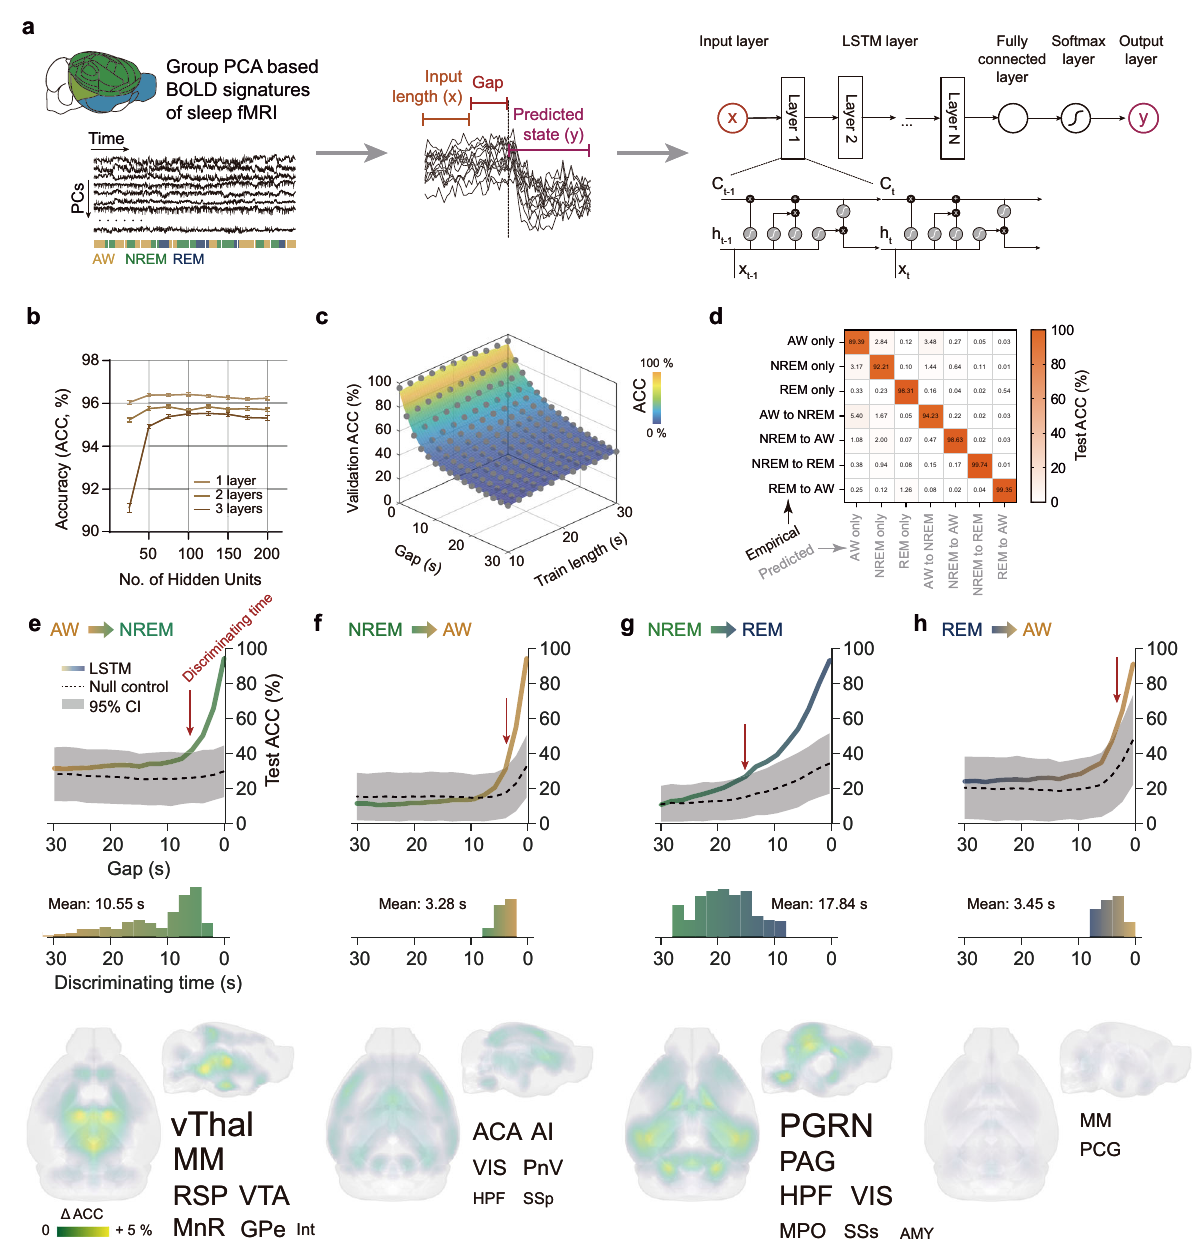
Fig. 5 | LSTM RNN Prediction of state transitions based on large-scale BOLD signatures. a Computational pipeline of the LSTM RNN model for state transition prediction. The model input was the BOLD signals (tPCs) preceding state transi- tions, and the output was the brain state after state transitions. Details were described in Methods part. b Mean (+/ − SEM, n =500 bootstrap sampling, same in all further analysis) prediction accuracy (ACC) of the LSTM RNN model on the validation dataset with different numbers of layers and hidden units. c Prediction accuracyonthevalidationdatasetwasprimarilyrelatedtothegaptimespreceding state transitions. Results were based on the LSTM RNN model with 1 hidden layer and 50 hidden units. Gray dot and colored shade represented an individual result and the corresponding best quadratic fi tting. d Confusion matrix between empirical and predicted seven categories showed high prediction accuracy on the testing dataset based on 10s input length, 0s gap times, 1 hidden layer and 50